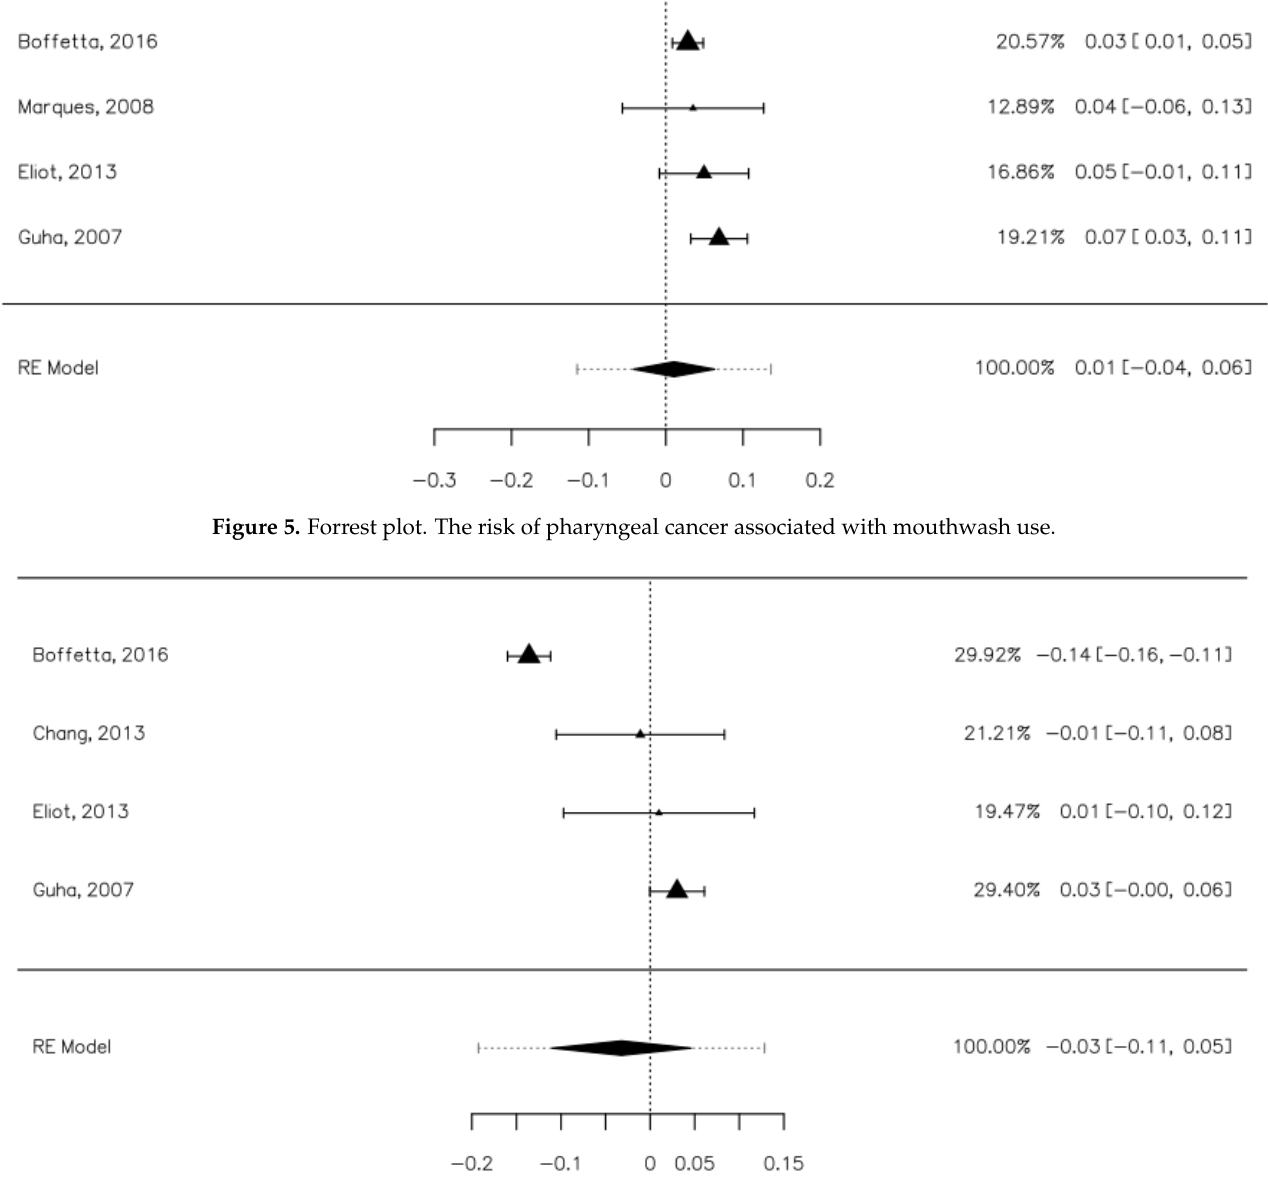
Figure 6. Forrest plot. The risk of oral laryngeal cancer associated with mouthwash use.